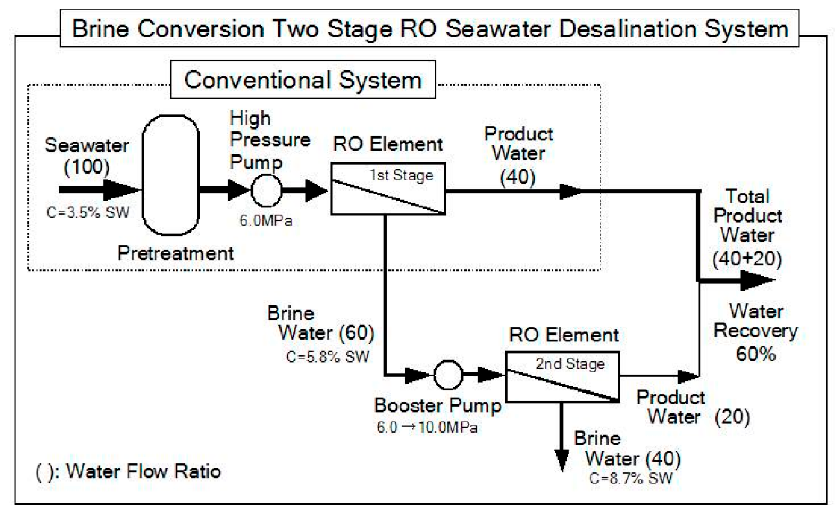
Figure 2. Two-stage brine conversion system (BCS) [25].